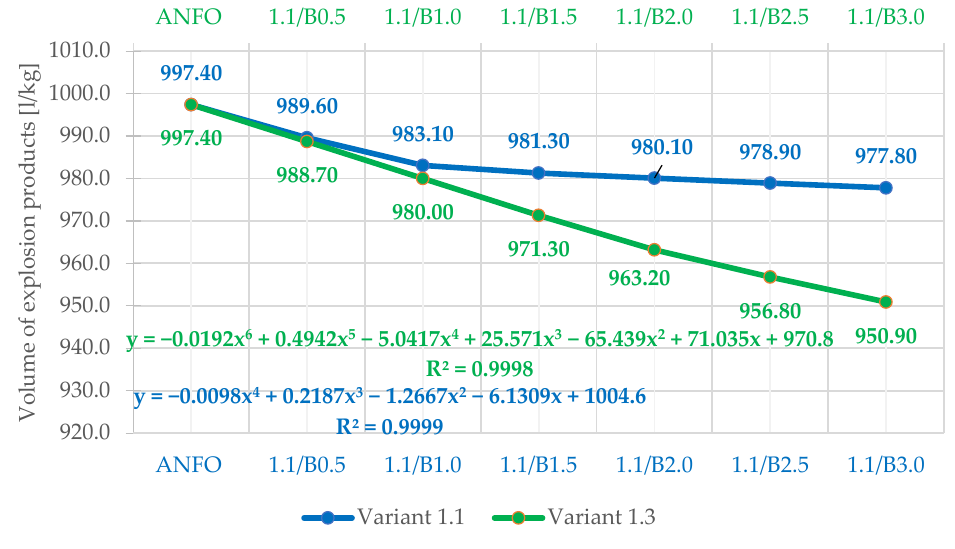
y = equation of the trendline function R 2 -the coefficient of the quality of the model fit Figure 4. Changes in the volume of explosive products for individual explosives.